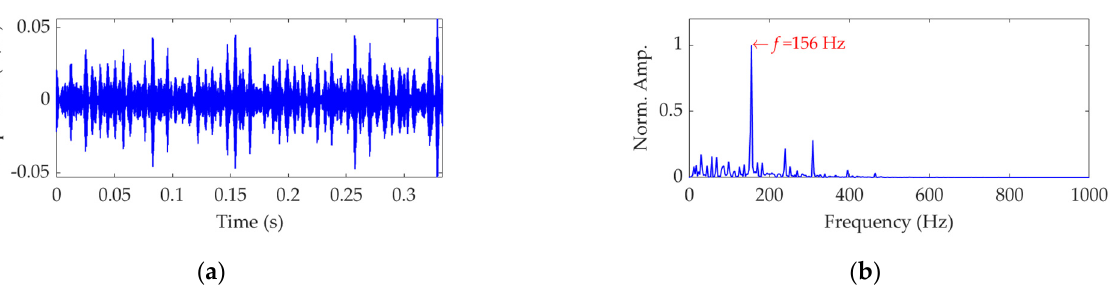
Figure 15. The optimal target mode: ( a ) time − domain waveform and ( b ) SES.